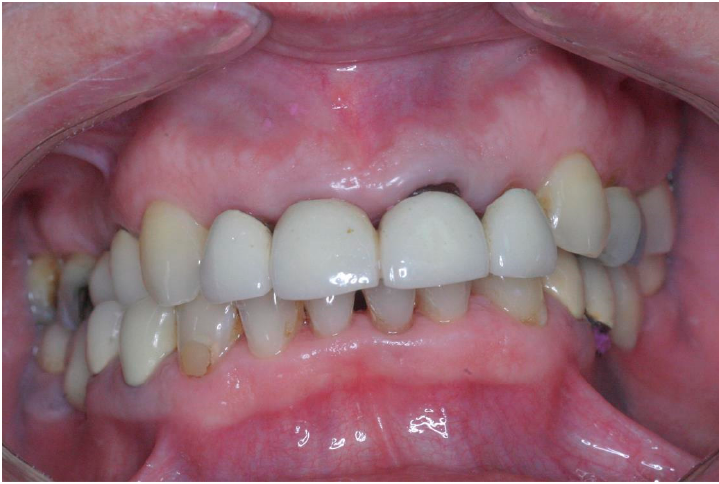
Figure 6. Sixty-year-old nonsmoking woman with hopeless 12–22 teeth due to severe carious lesions (patient #29).